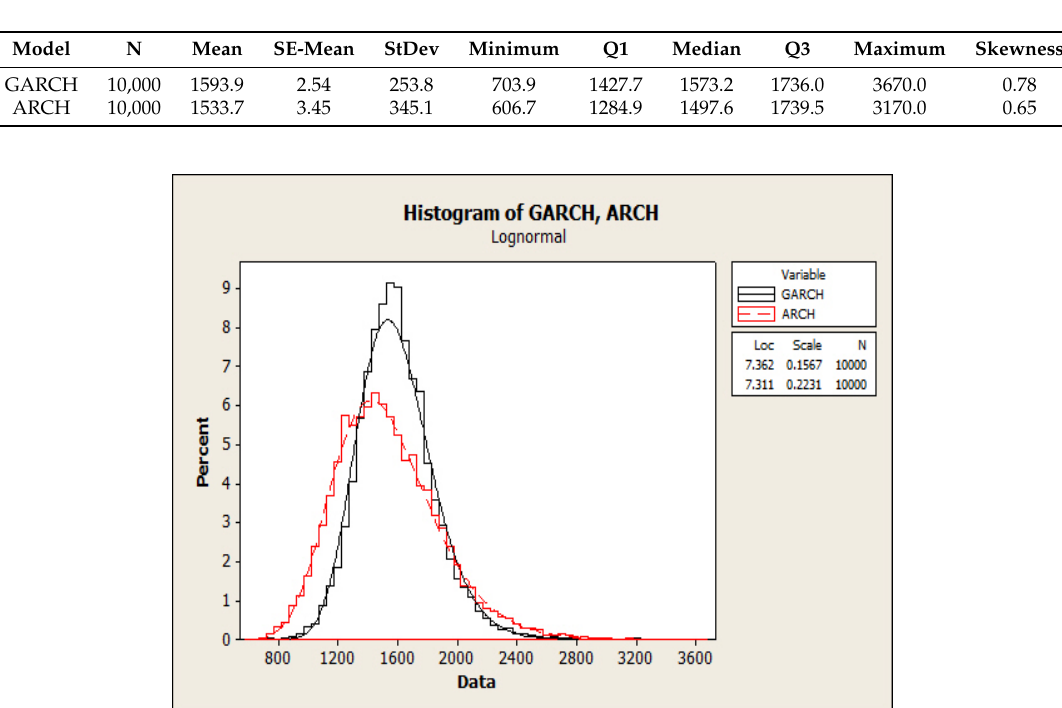
Figure 16. Terminal